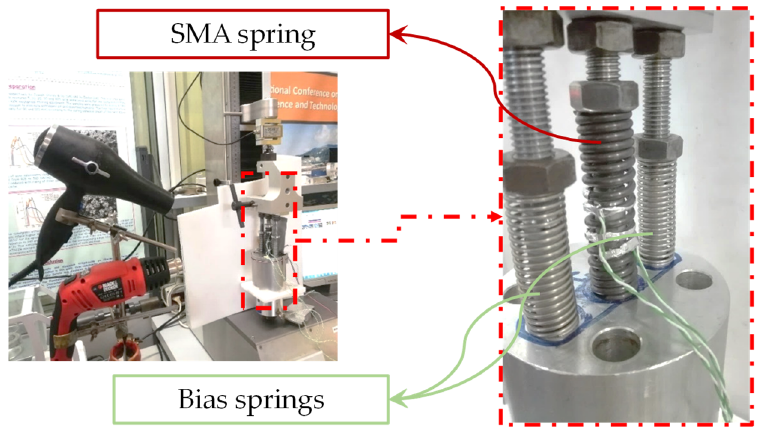
Figure 18. Heating and cooling system for actuator test and zoomed image of the sized bias-SMA based springs.